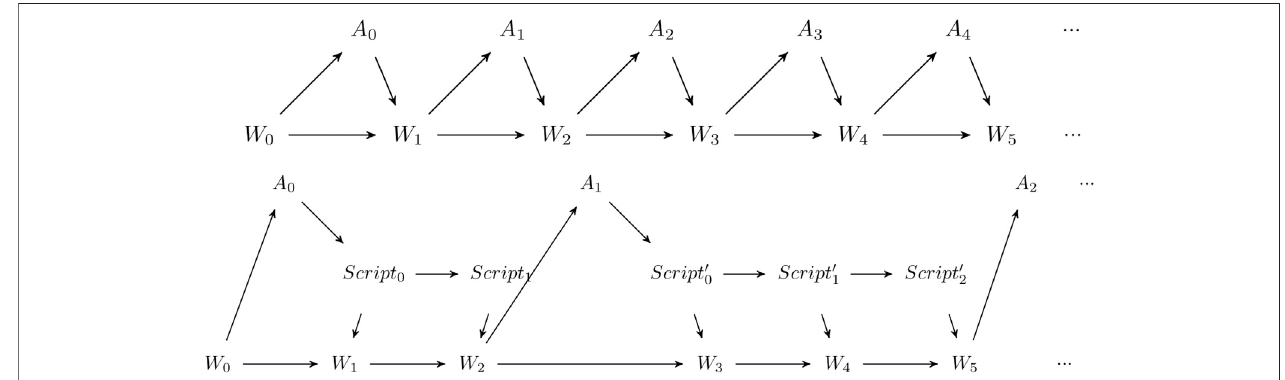
FIGURE 1 | Top: Bayes Network of the perception-action loop of an agent with only basic actions. During every time step, the agent perceives the world. Bottom: TheBayesNetworkoftheagent ’ sperception-actionloopwithanintermediatescript-layer.Theagentisonlyabletoperceiveandreacttotheworldatsomepointsintime after the script is fi